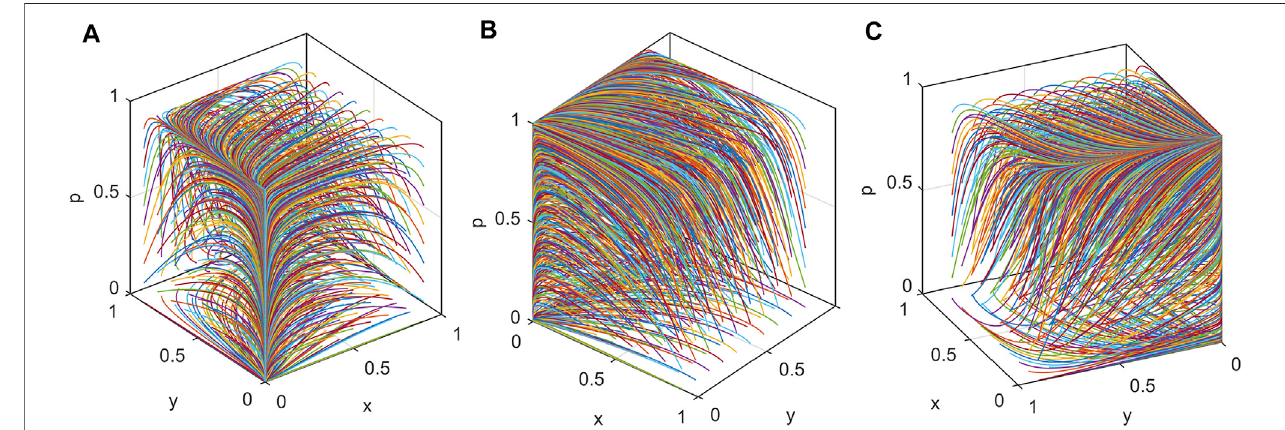
FIGURE 9 | The impact of penalty cost. (A) when the situation is (6, 4.61, 2). (B) when the situation is (12, 10.61, 8). (C) when the situation is (18, 16.61,